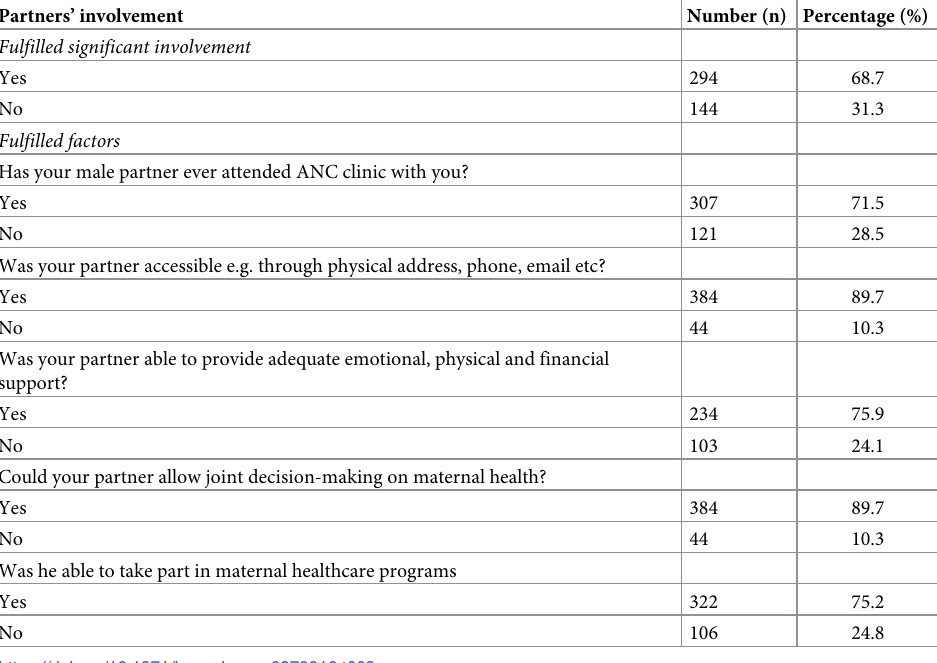
Table 2. Percentage distribution of factors for male involvement in antenatal care in the studied group (N = 428). Partners’